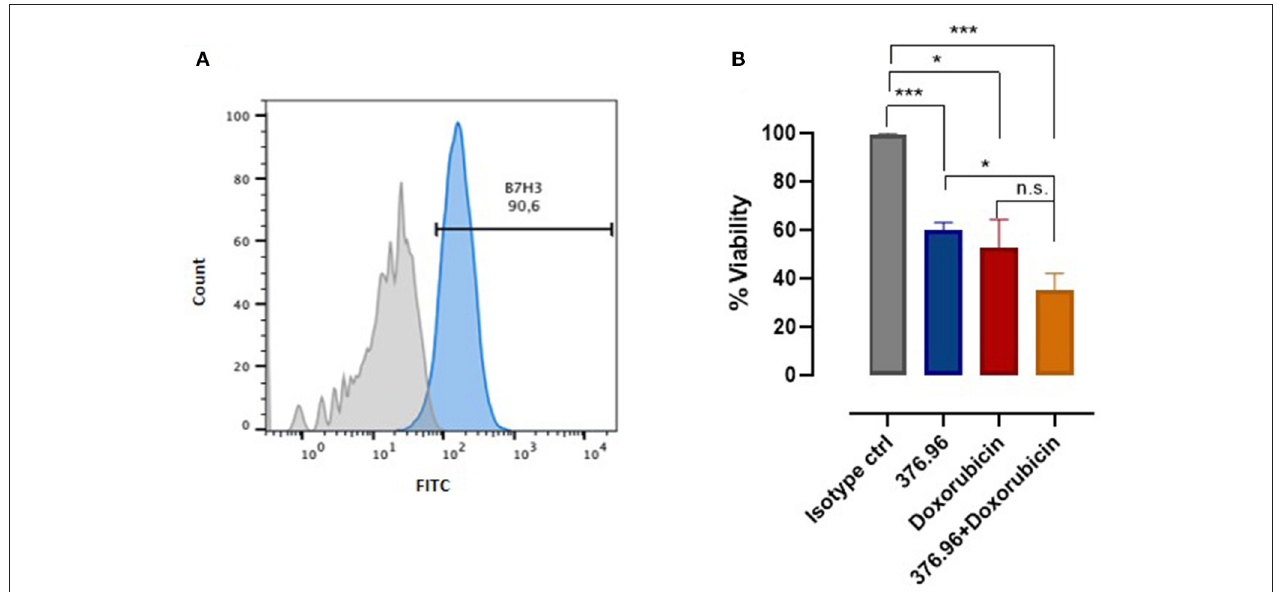
FIGURE 1 | B7-H3 expression and targeting in OMM. (A) Flow cytometry analysis of B7-H3 expression on canine CMM-12 OMM cells performed using a FACS Verse (BD Biosciences). The results were analyzed using FlowJo software and representative FACS curves are reported, showing CMM-12 staining using a control IgG1 isotype (filled gray area) and the anti-human B7-H3 mAb 376.96 (filled blue area; 25 µ g/ml final concentration). (B) Cell proliferation assessed using an MTT assay, as described in (73). The results are expressed as the percentage (mean value ± SEM) of the viability of cells treated with anti-B7-H3 mAb, with respect to cells treated with the control IgG1 isotype, considered as 100%, alone or in combination with doxorubicin at a final concentration of 0.5 µ M. Graph shows the results of three independent experiments. Student’s t -test: * p < 0.01; *** p <